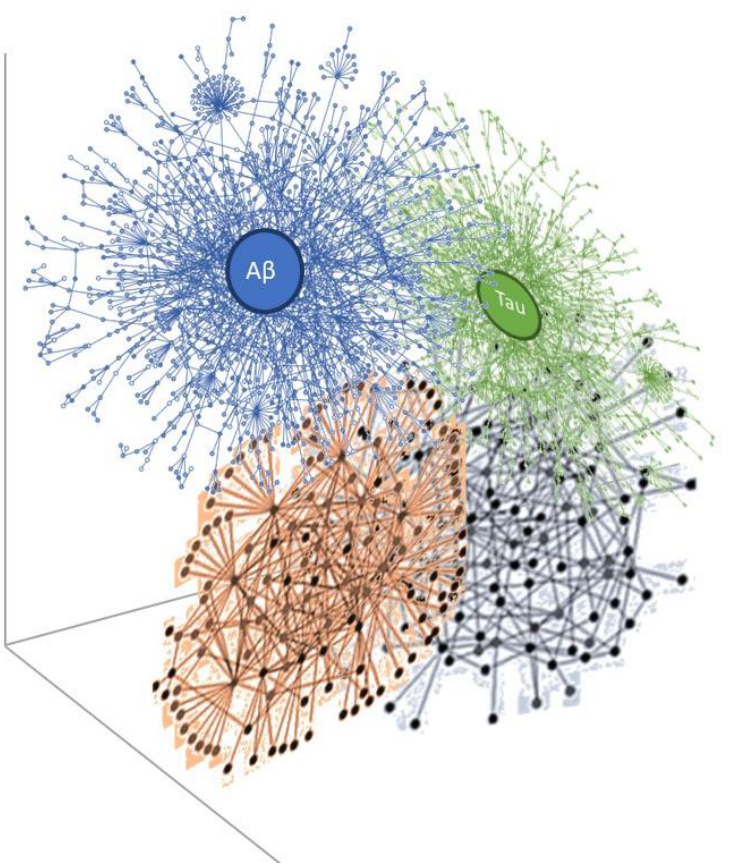
Figure 5. The interaction of protein networks and collisions in Alzheimer’s disease, as an example of neurodegeneration, with engagement of known proteins Aβ and tau, and yet-to-be-discovered proteins—unlabeled.